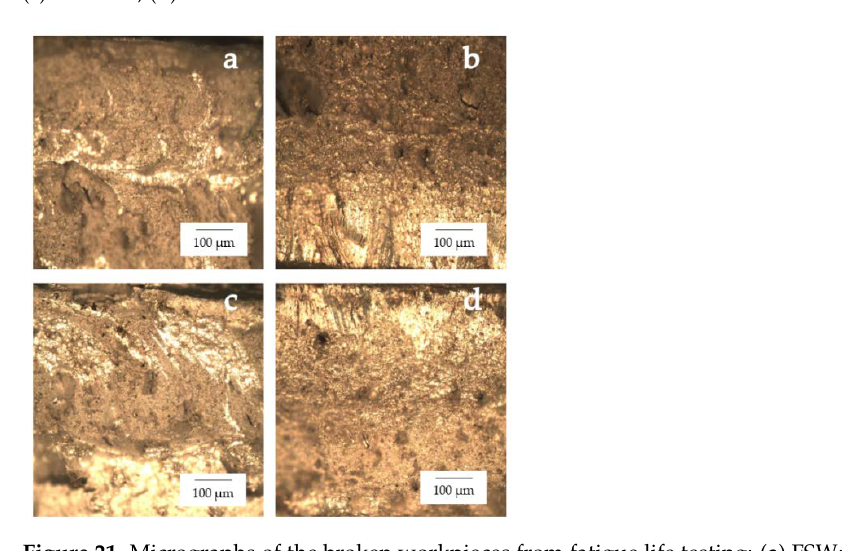
Figure 21. Micrographs of the broken workpieces from fatigue life testing: ( a ) FSW; ( b ) FSW-PWHT; ( c ) FSW-DR; ( d ) FSW-PWHT-DR.